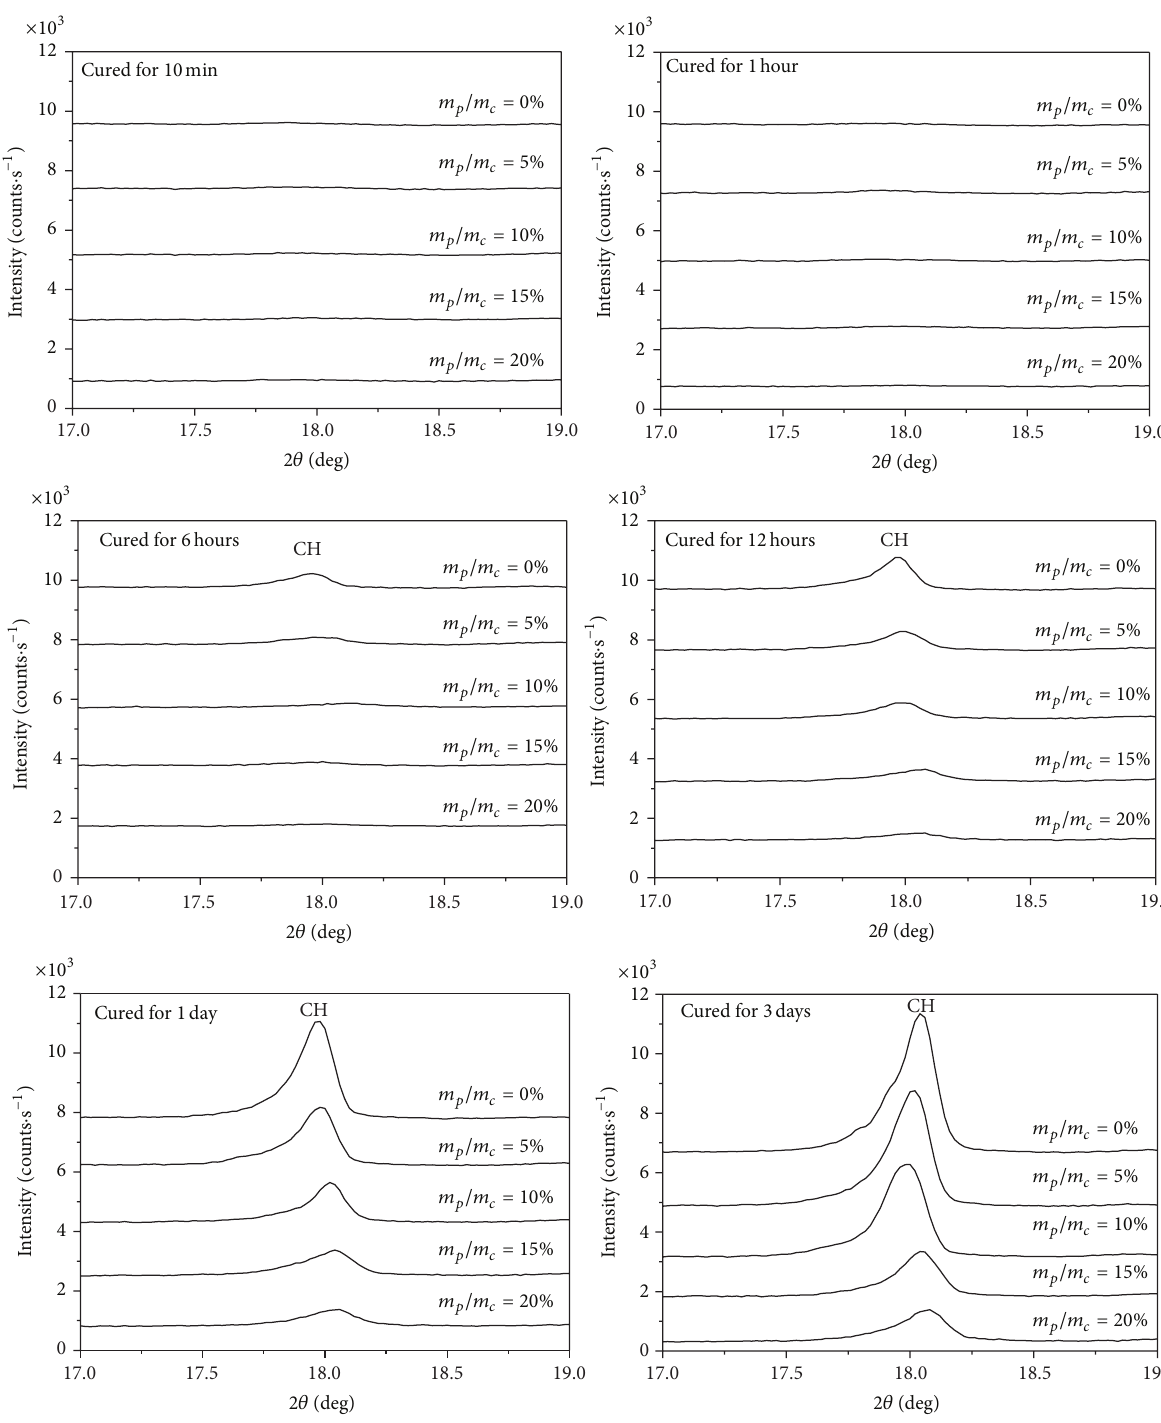
(Figure 5(g)). When adding SAE dispersion, cluster-like C-S- H gel also appears which replaces SAE particles and C 4 AH 13 present after 6 hours, and meantime some polymer films are observed on the surface of the hydrates (Figure 5(h)). However, the C-S-H gel content is much less and its appearing